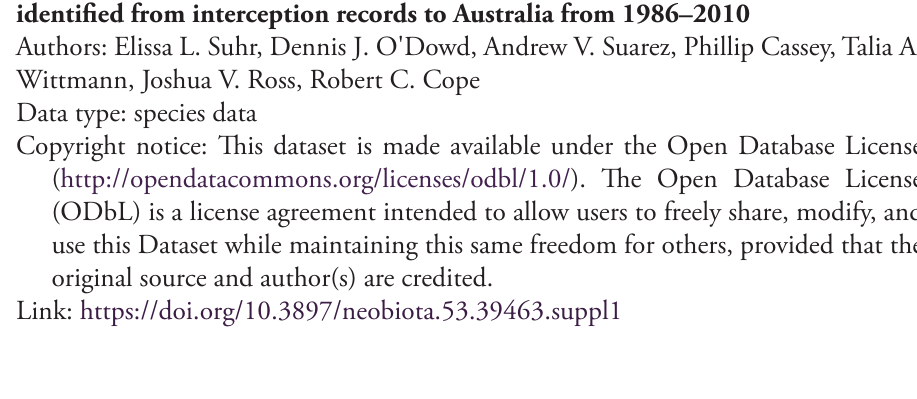
Table S1. Ant species (or species group), number of records and status of ants identified from interception records to Australia from